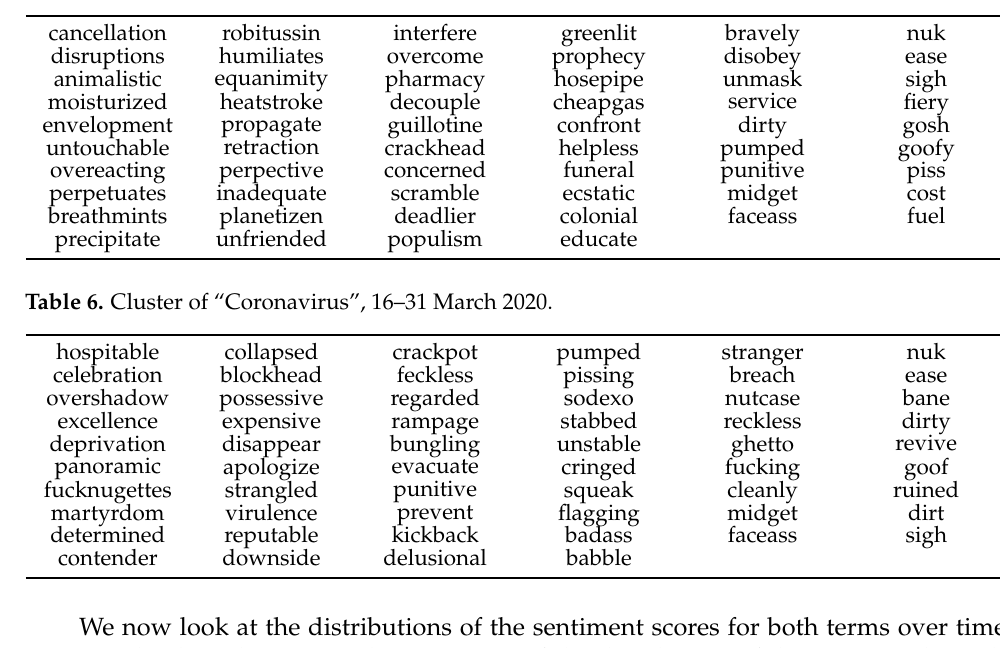
Table 5. Cluster of “Coronavirus”, 1–15 March 2020.